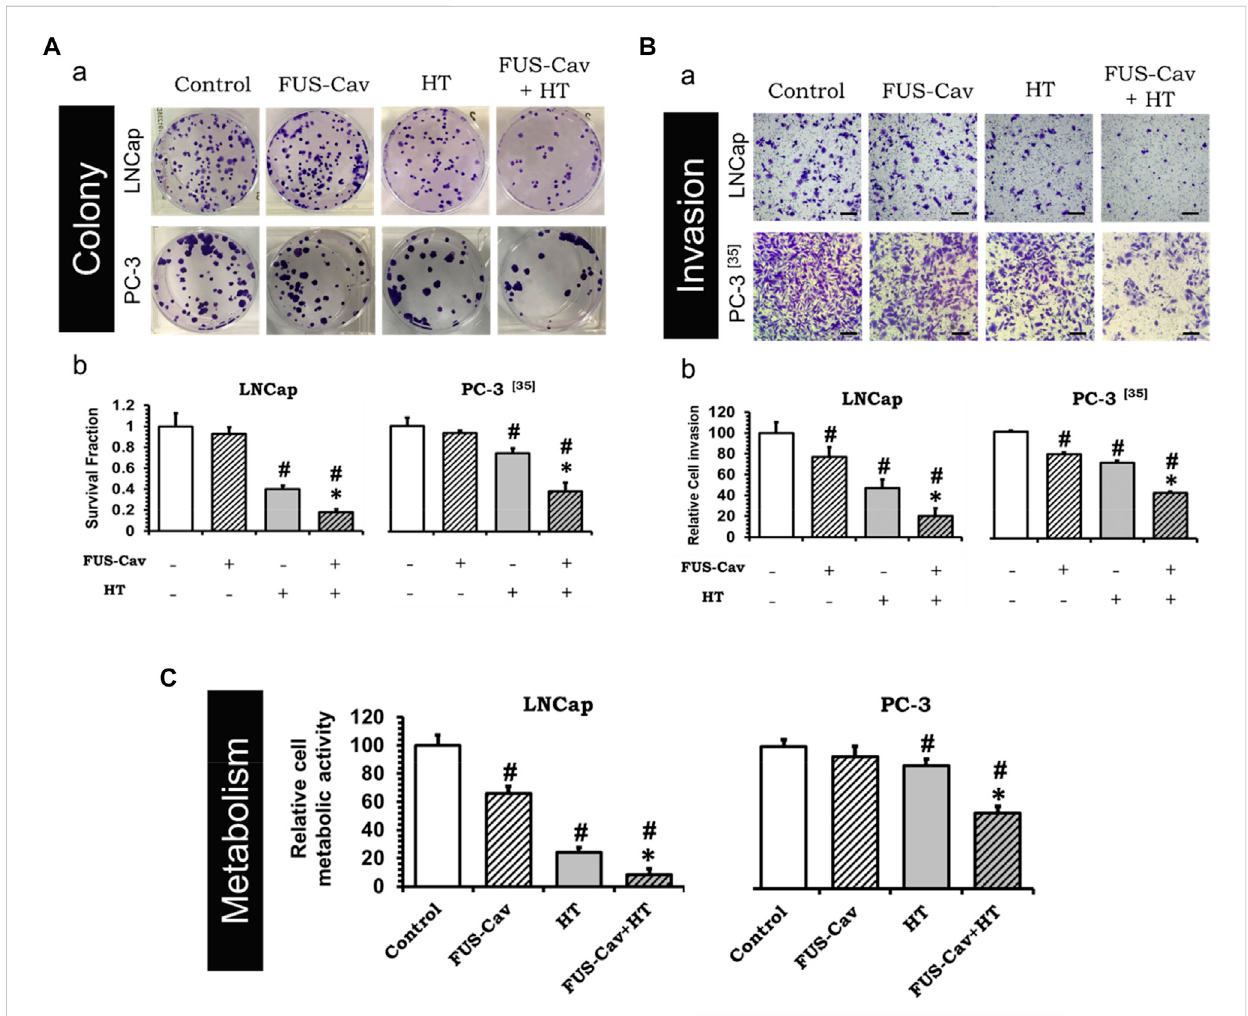
FIGURE 3 FUS-Cav(1136 W/cm 2 ,40 s)demonstratedadditiveeffecttoHT(45 ° C,30 min). (A) a:RepresentativeimagesofcolonyformationinLNCapandPC-3 cells 21 days post-treatment. Cell survival fraction was calculated as the counted colonies divided by the product of the seeding number and the plating ef fi ciency. b: Cell survival fraction diagrams of LNCap and PC-3 (Hu et al., 2020) cells, suggesting the ability of a single cell to grow into a colony after various treatments. (B) a: Representative microscopy images of Transwell ® assay in LNCap and PC-3 (Hu et al., 2020) cells 48 h post-treatment. Scale bar = 100 μ m. b: Relative cell invasion of LNCap and PC-3 (Hu et al., 2020) cells derived from semi-quantitative analysis of the Transwell ® assay revealingcellinvasivepotential48 hpost-treatment. (C) RelativecellularmetabolicactivitywasdetectedbyWST-1assay72 h(forLNCap)or48 h(forPC- 3) post-treatment. Data were normalized to untreated control, which was set to 100%, and relative values are presented as mean ± SEM, n = 6, *signi fi cantly different from HT ( p ≤ 0.05), # signi fi cantly different from control ( p ≤